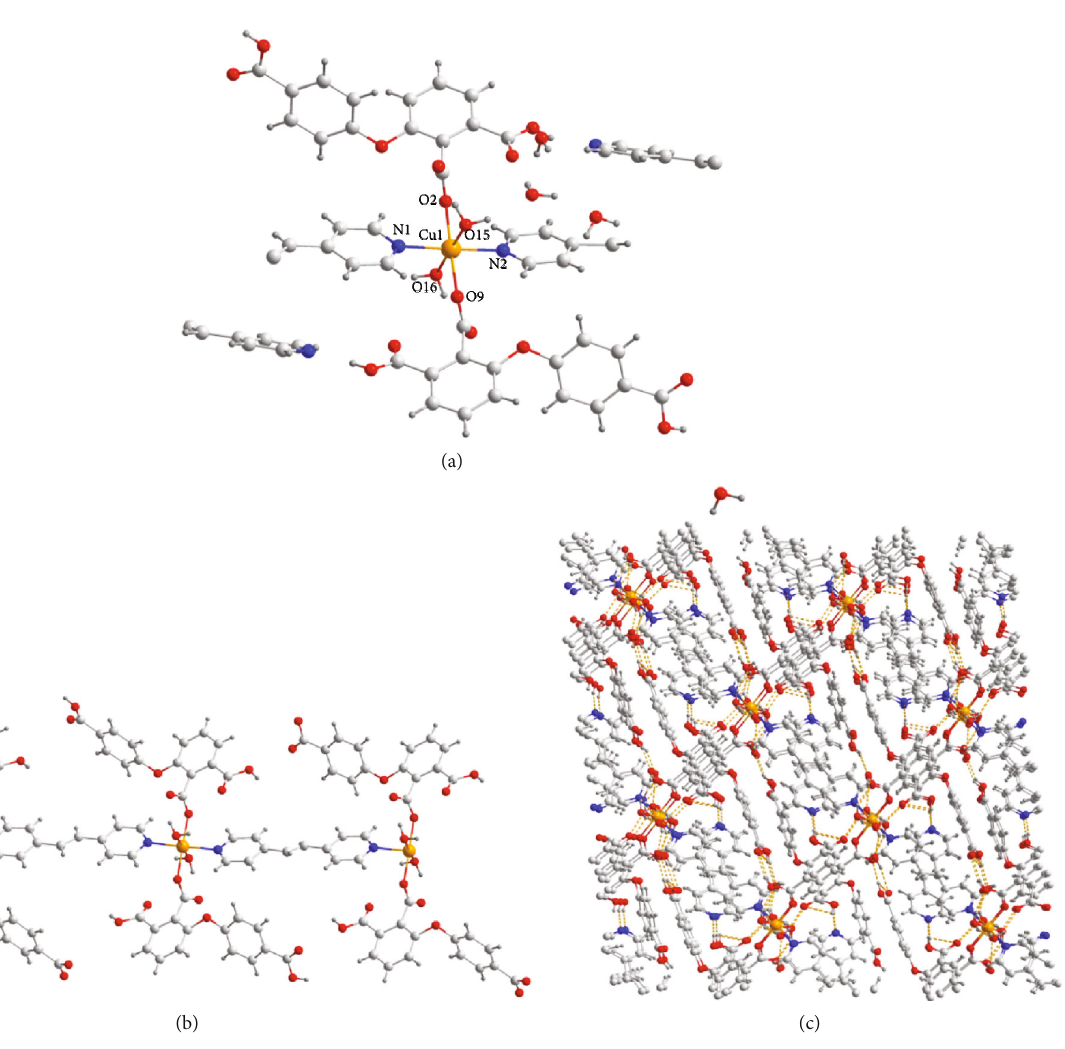
Figure 1: (a) The coordination surrounding diagram for the Cu ions. (b) The 1-dimensional chain architecture of compound 1. (c) The 1 ’ s 3-dimensional supramolecular